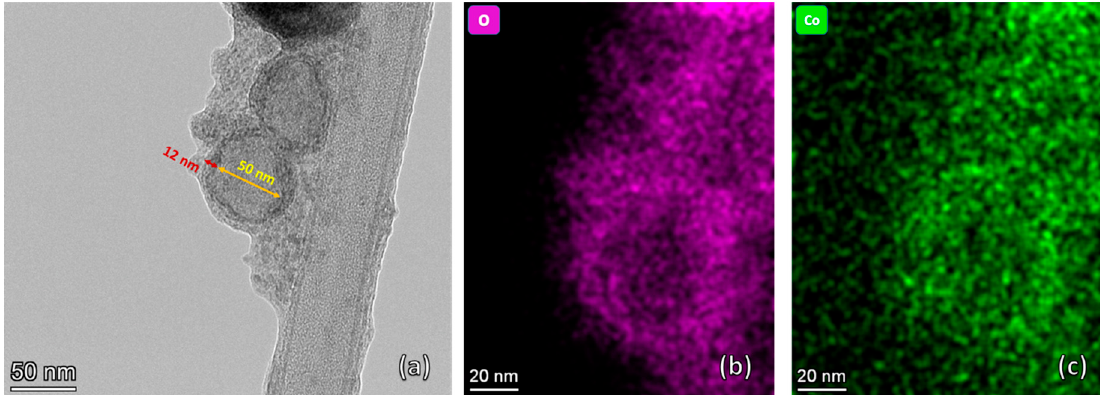
Figure 6. TEM image ( a ) and EDS mapping images ( b , c ) of OMO(5) showing a core/shell structure with oxygen ( b ) and cobalt ( c ).